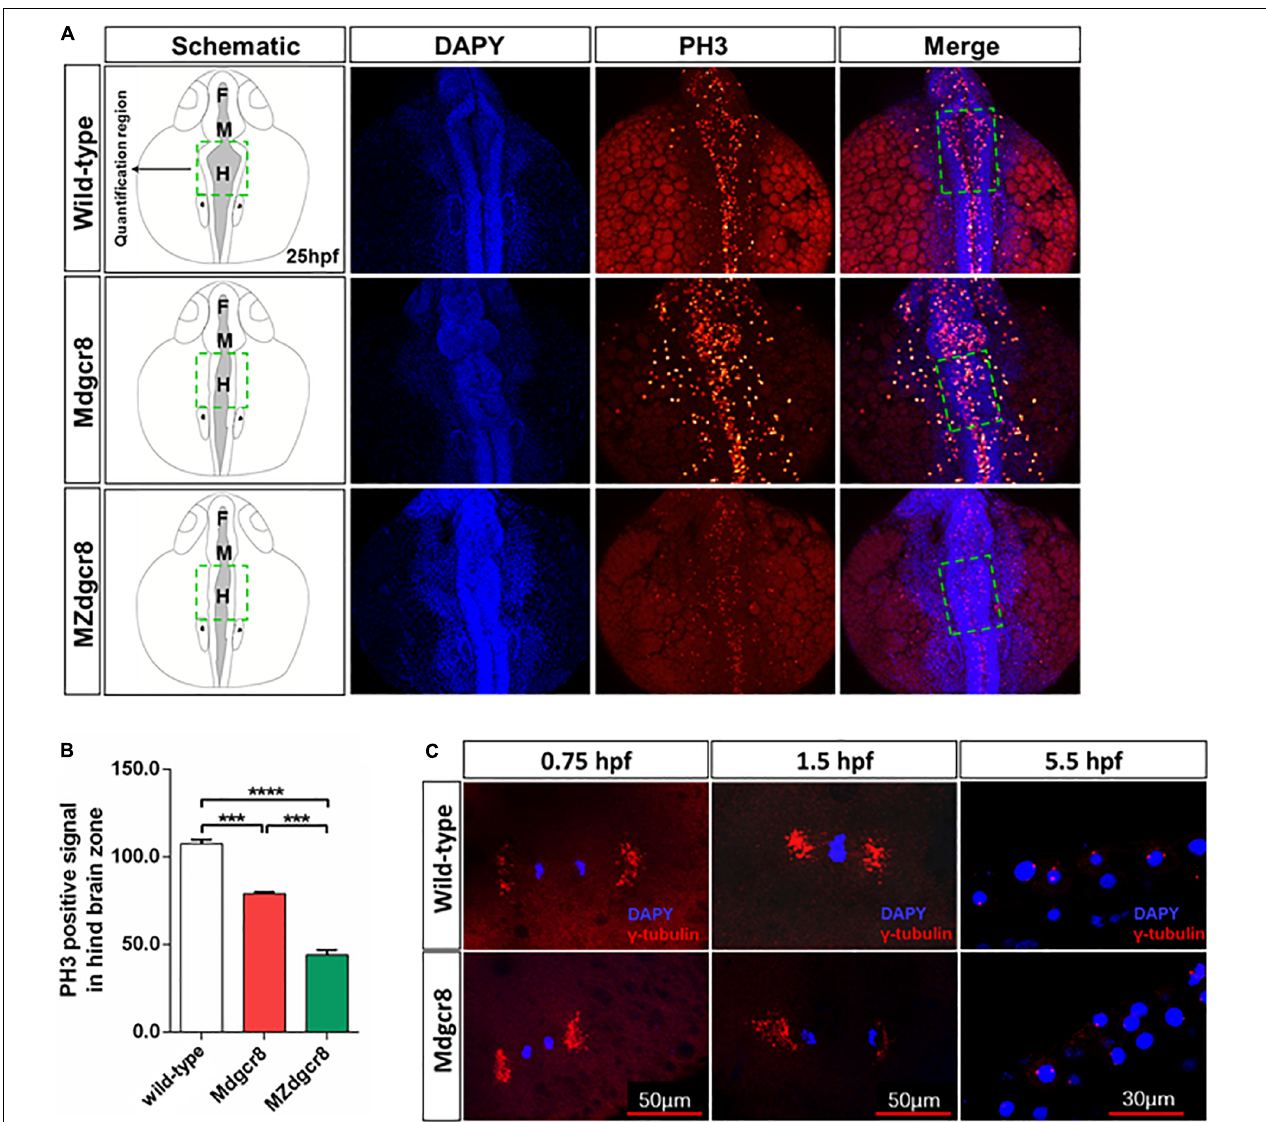
FIGURE 3 | Maternal Dgcr8 regulates mitosis during early embryonic development in M dgcr8 and MZ dgcr8 . (A) Representative images of 25 hpf WT, M dgcr8 and MZ dgcr8 embryos showing the distribution of PH3 immunolabeling cells (B) and quantification of positive cells in the hindbrain before the otic vesicle in the dashed box region ( N = 3). (C) Mitotic centrosomes were detected using γ -tubulin immunostaining. *** p < 0.001 and **** p <